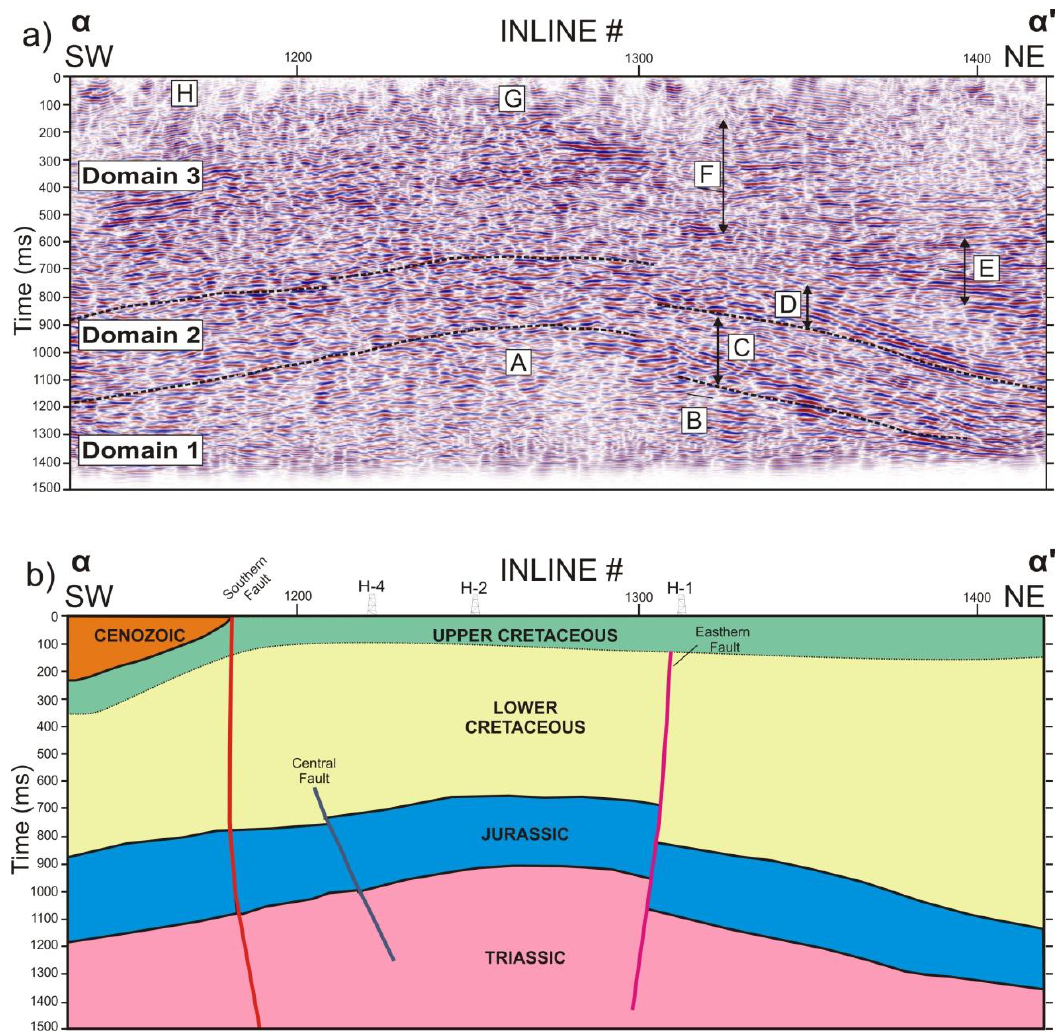
Fig. 12. Section β - β 0 of the Hontomín data set, (a) processed with Alcalde et al. (2013) processing flow, and (b) with the processing flow outlined in Table 2. Location of the β - β 0 section in Fig. FIG. 12: (a) Migrated section (up to processing step 25 in table 2) from α-α’ section